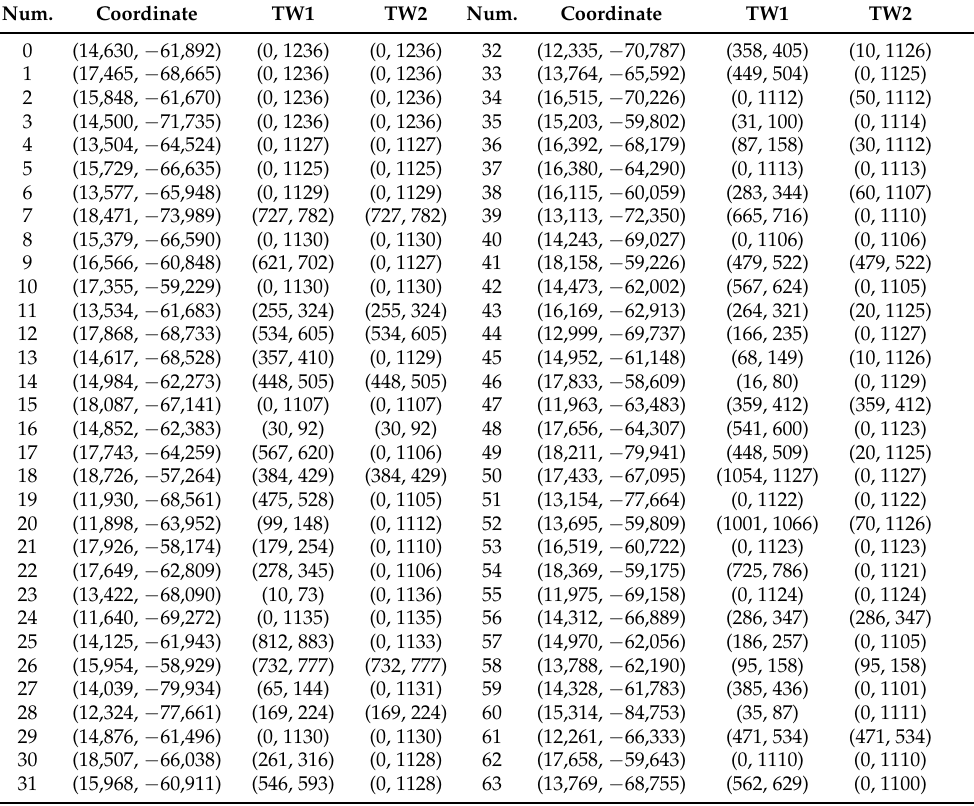
Table 5. The time windows and coordinates of two cases.